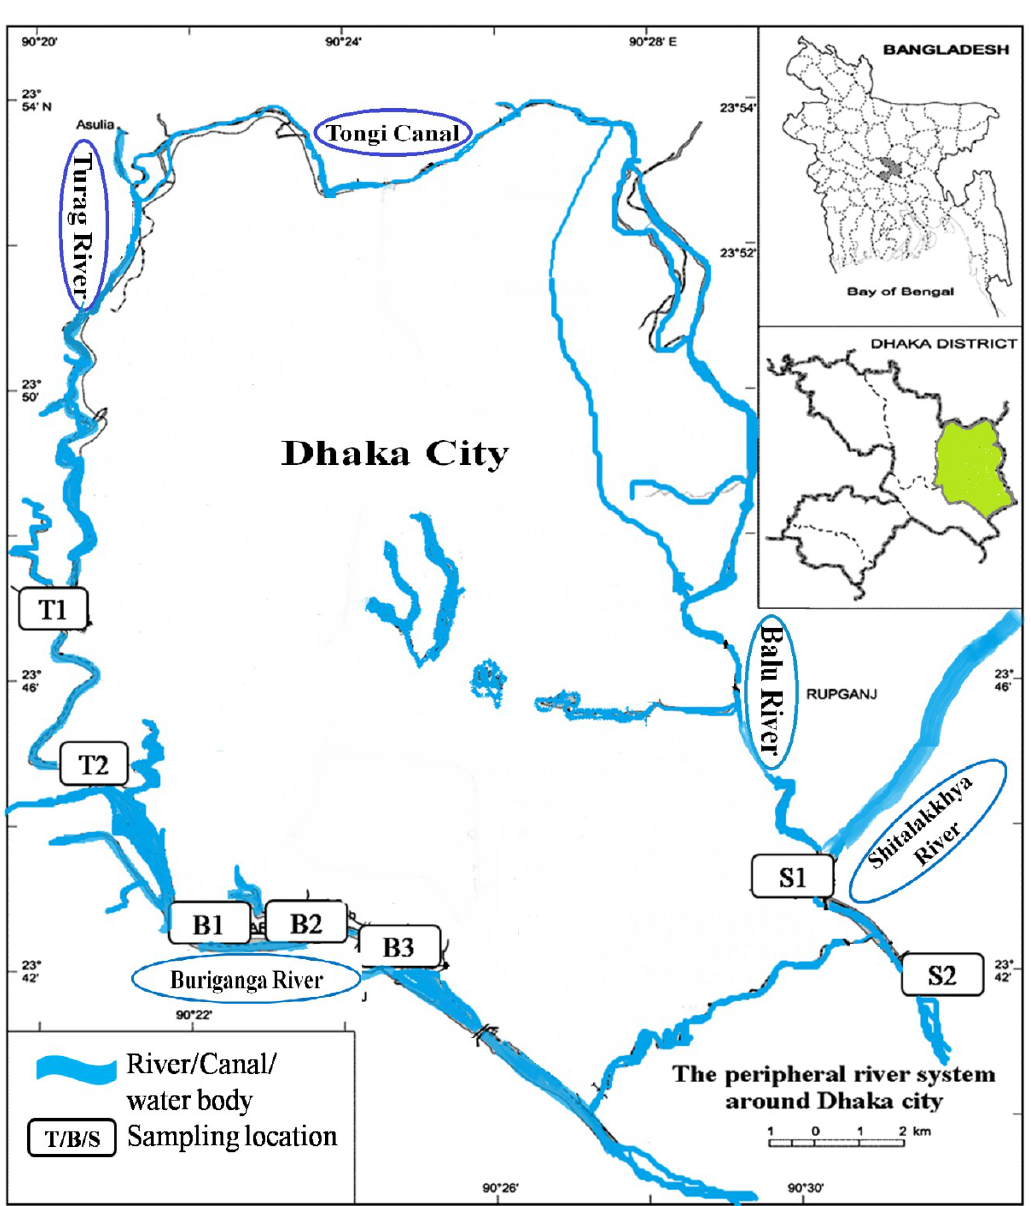
Figure 2. The sampling points in three main rivers around Dhaka City. The designations T1, B1, S1 represent the upstream and T2, B2, B3, S2 represent the downstream of each